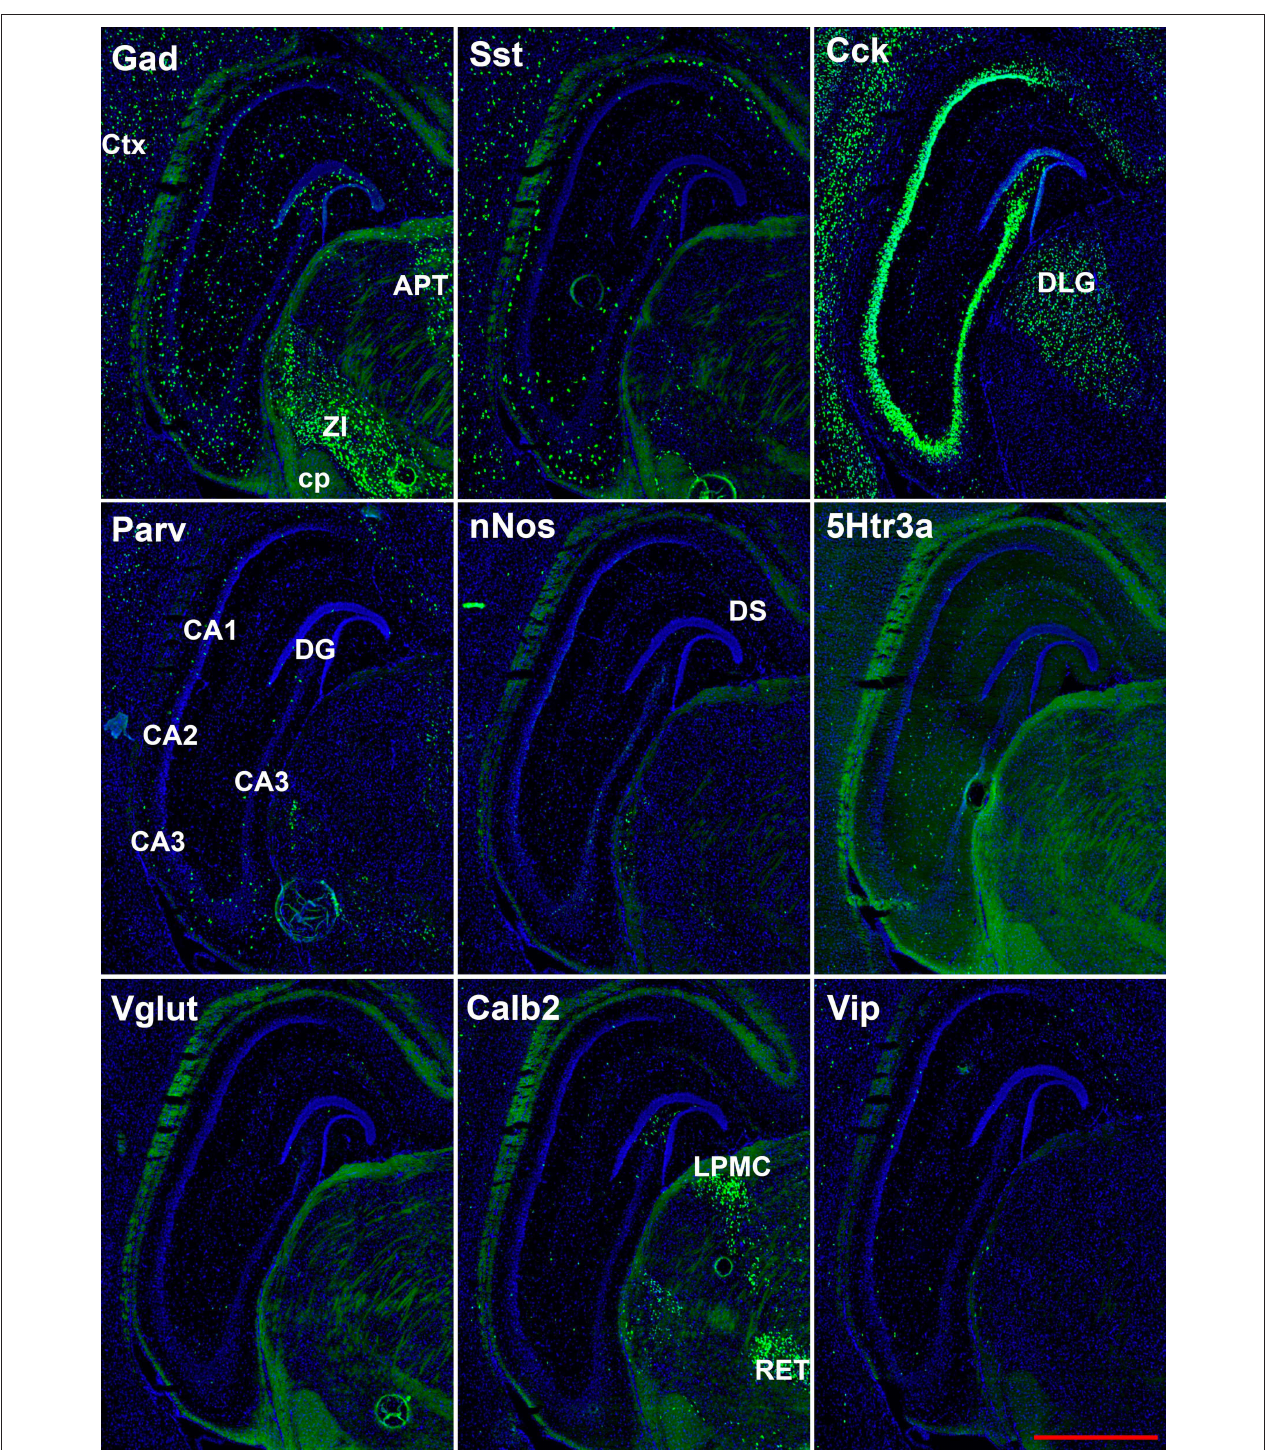
FIGURE 4 | Representative low-magnification photomicrographs showing expression of nine interneuron types 2.6mm behind the bregma. White matter tracts show some autofluorescence (green) in some panels. Bar equals 1mm for all panels. APT, anterior pretectal n. caudal; cp, cerebral peduncle; Ctx, neocortex; DLG, dorsal lateral geniculate; DS, dorsal subiculum; LPMC, lateral posterior nucleus mediocaudal; RET, retroethmoid nucleus; ZI, zona incerta. The bar equals 1mm for all panels.